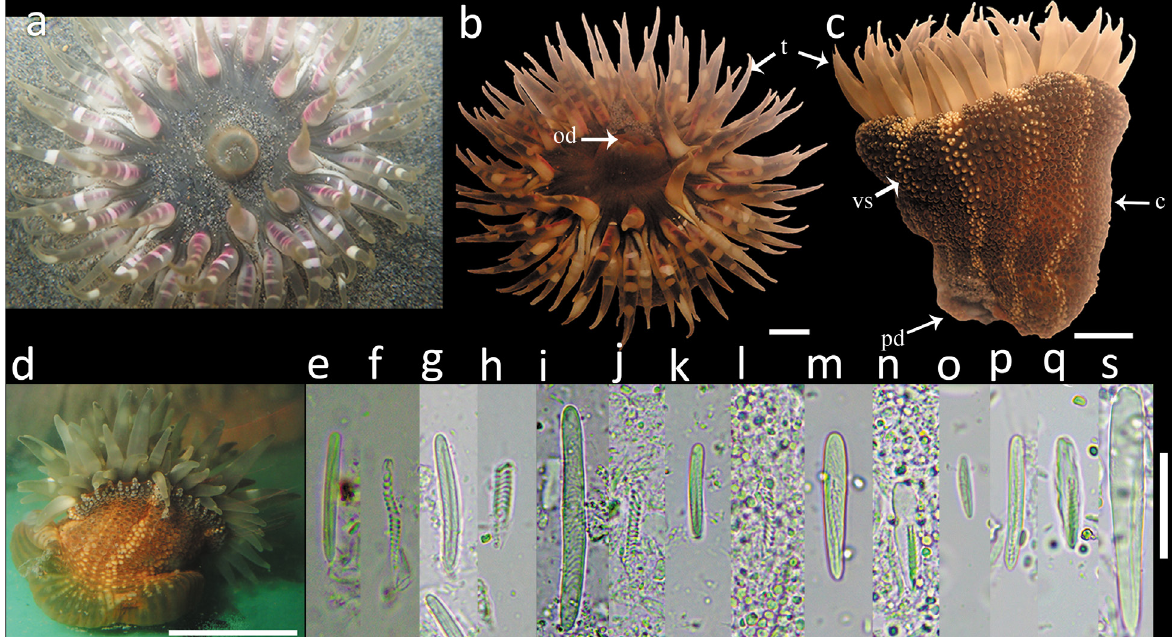
Figure 4. Bunodosoma granuliferum (Le Sueur, 1817). a live specimen in natural habitat. b oral view. c lateral view. d lateral view of the second specimen. e-s Cnidae. - tentacle: e basitrich f spirocyst; acrorhagi: g basitrich h spirocyst i holotrich; column: j spirocyst k basitrich; actinopharynx: l spirocyst m basitrich n microbasic p -mastigophore; filament: o small basitrich p basitrich q microbasic p -mastigophore s microbasic b -mastigophore.